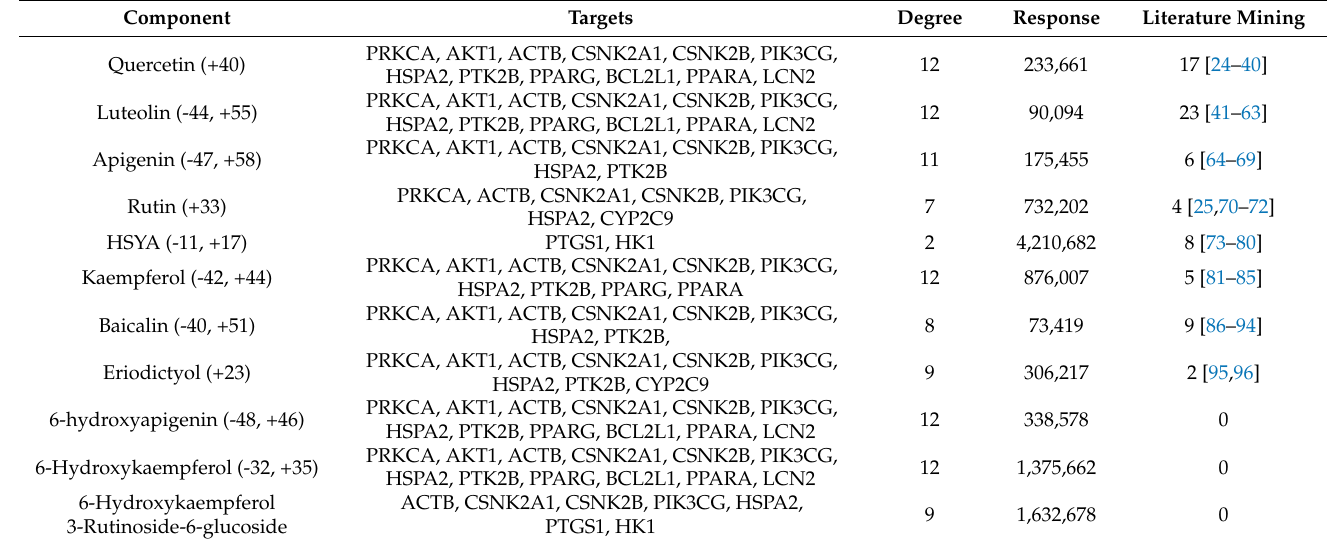
Table 2. The key components filtered from the